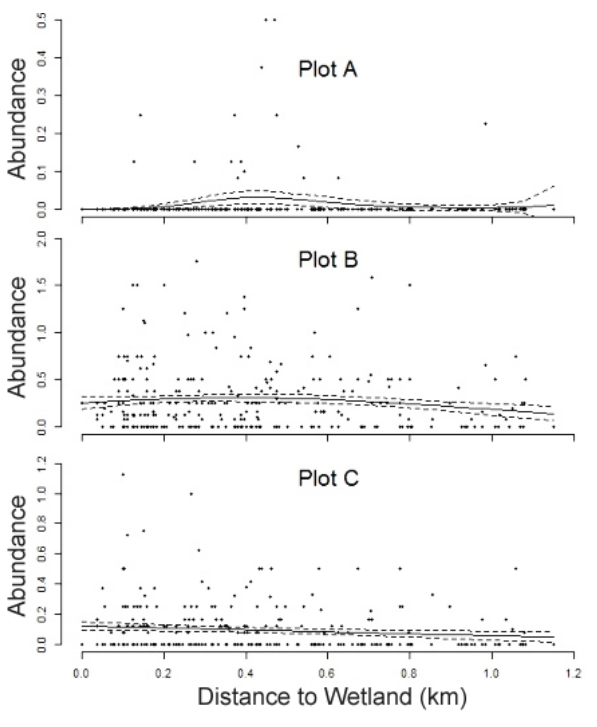
Fig. 3 . Response of Long-billed Curlew ( Numenius americanus ; plot A), Marbled Godwit ( Limosa fedoa ; plot B), and Willet ( Tringa semipalmata ; plot C) to wetland edge habitat in southern Alberta, Canada, 2000-2002. Each species’ abundance decreased above 0.4 km from wetlands. Figure produced using R graphing software (R Core Team